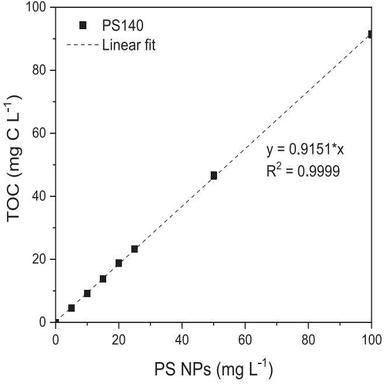
Calibration curve of Total Organic Carbon (TOC) vs. PS NPs concentration ( = 0 − 100 mg/L and D0 = 140 nm).